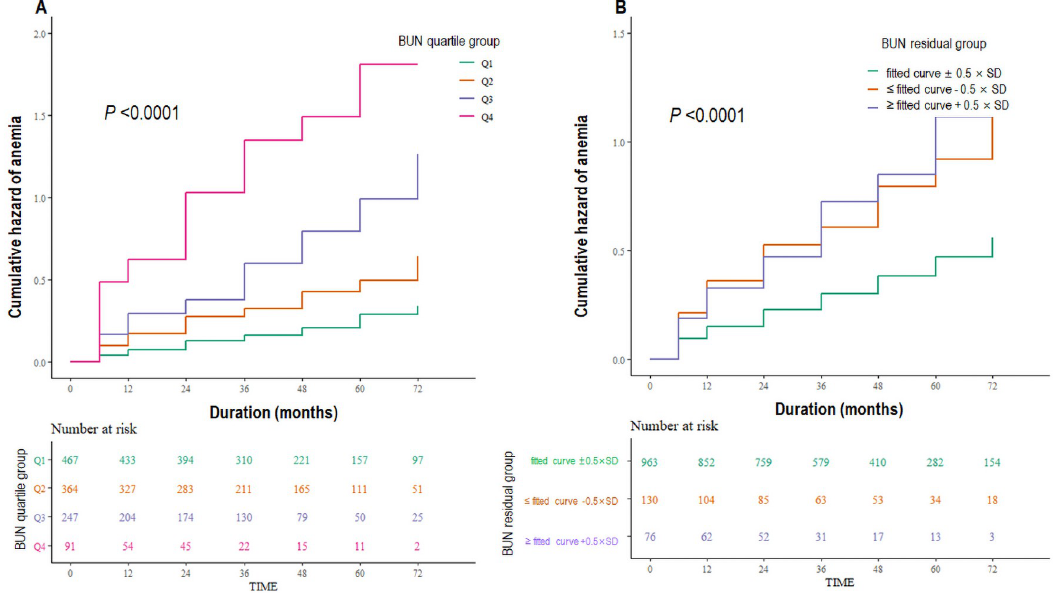
Fig 3. Kaplan-Meier curves for anemia development according to the BUN quartiles and BUN residual groups. 3A . The higher BUN quartile groups had a significantly higher cumulative hazard of anemia development ( P < 0.0001). 3B. Compared to the group with BUN residual in the fitted curve ± 0.5 × SD, the BUN residual group � fitted curve + 0.5 × SD and � fitted curve– 0.5 × SD had a significantly higher cumulative hazard of anemia development ( P < 0.0001). BUN, blood urea nitrogen; SD, standard